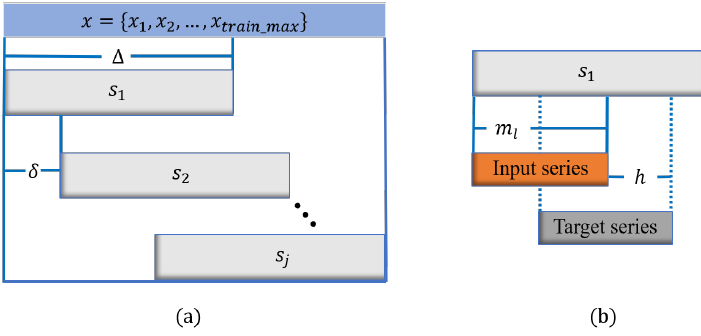
Figure 1. The two-stage sliding window strategy. ( a ) The first sliding window performed on the training set. The data involved are x 1 to x train _ max , which is the last element of the training set. It has a time window length, ∆ and sliding step, δ , and the split segment are indicated by s 1 up to s j , the last segment containing x train _ max . ( b ) Segment s 1 is segmented by m is the input length and target series bearing the forecasting interval h .